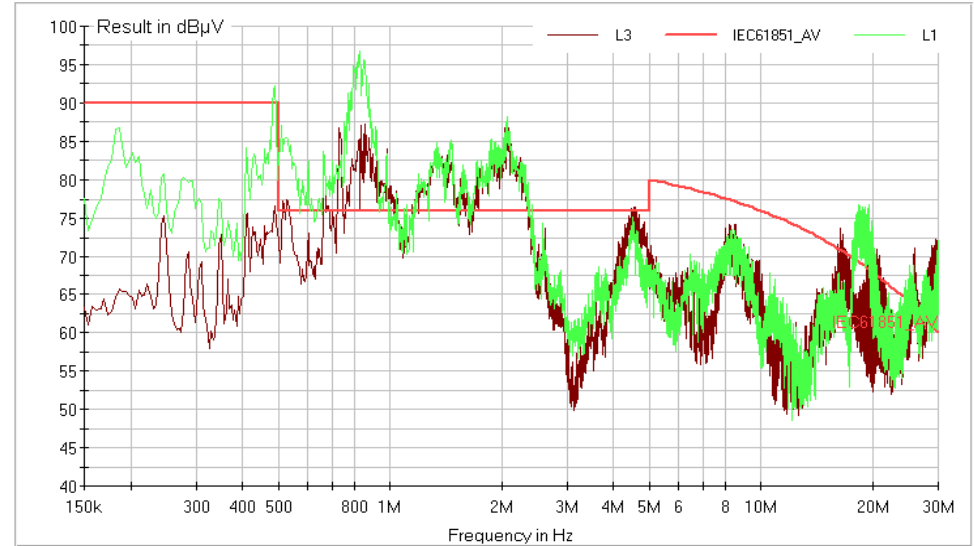
Figure 9. Conductive disturbance of the charging station, DC module operation (80% of power).